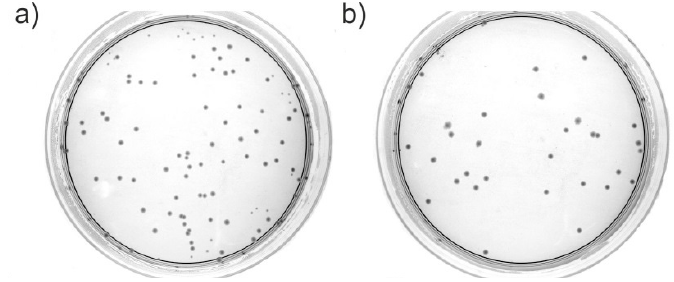
Figure 2. Comparison of Petri dishes cultured using ( a ) the E. coli reference sample and ( b ) the E. coli sample exposed to HND in the LB medium for 5 h.